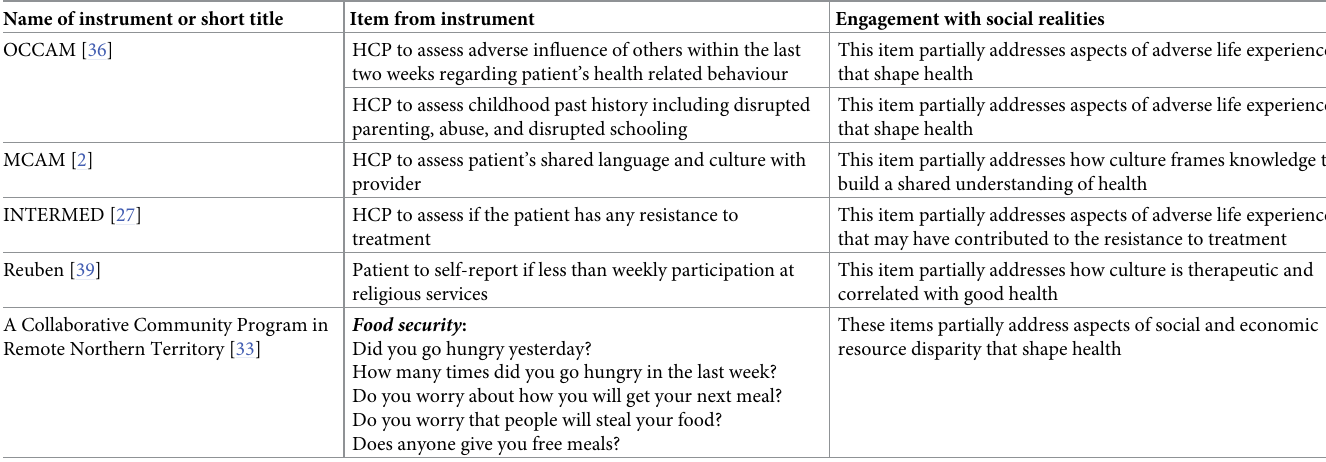
Table 3. Items engaging social realities.